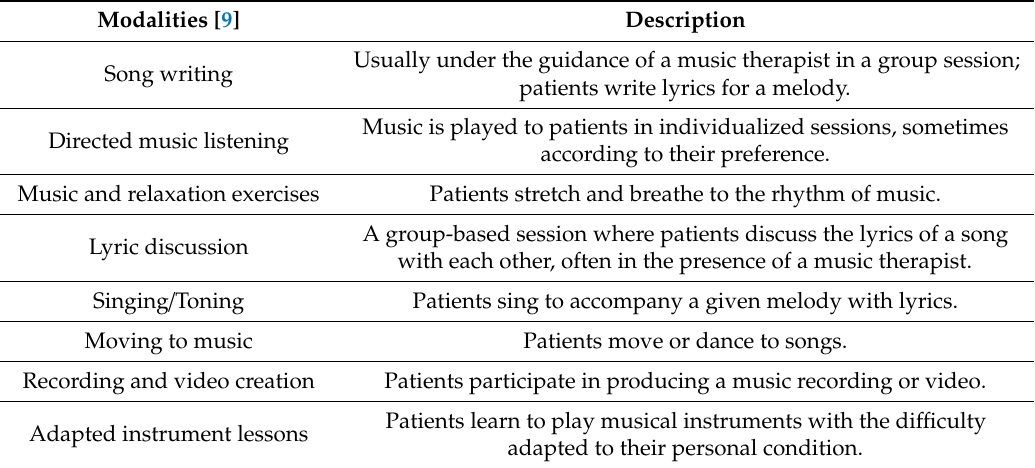
Table 1. Modalities of music